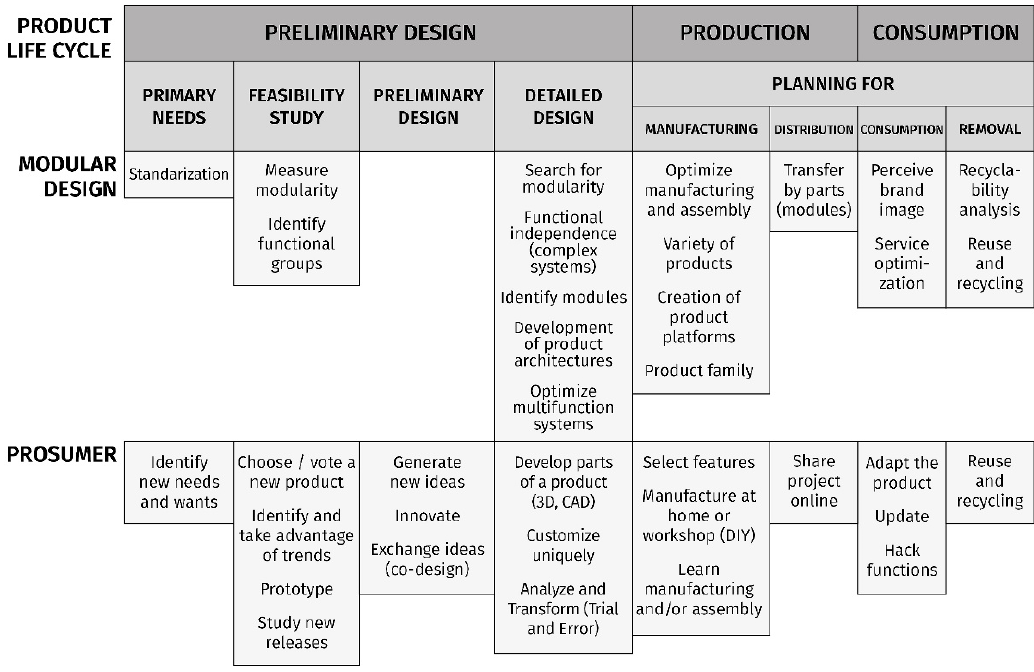
Figure 1. Phases of the product life cycle and the relationship to modular design and prosumer goals.